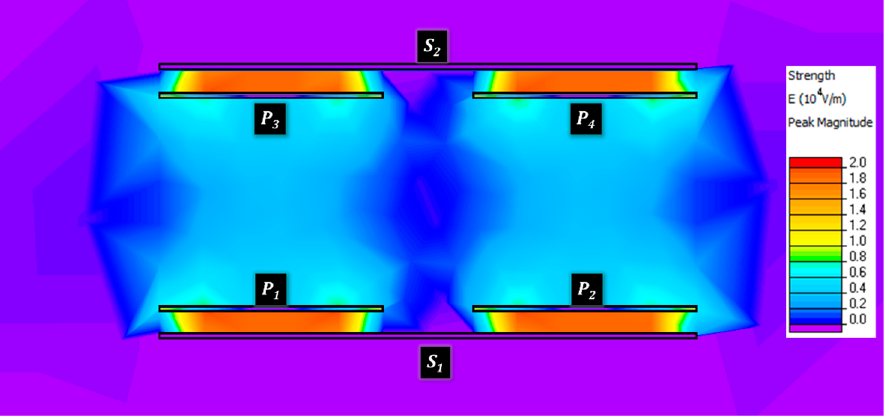
Figure 23. The EF emission of shielded-CPT system.